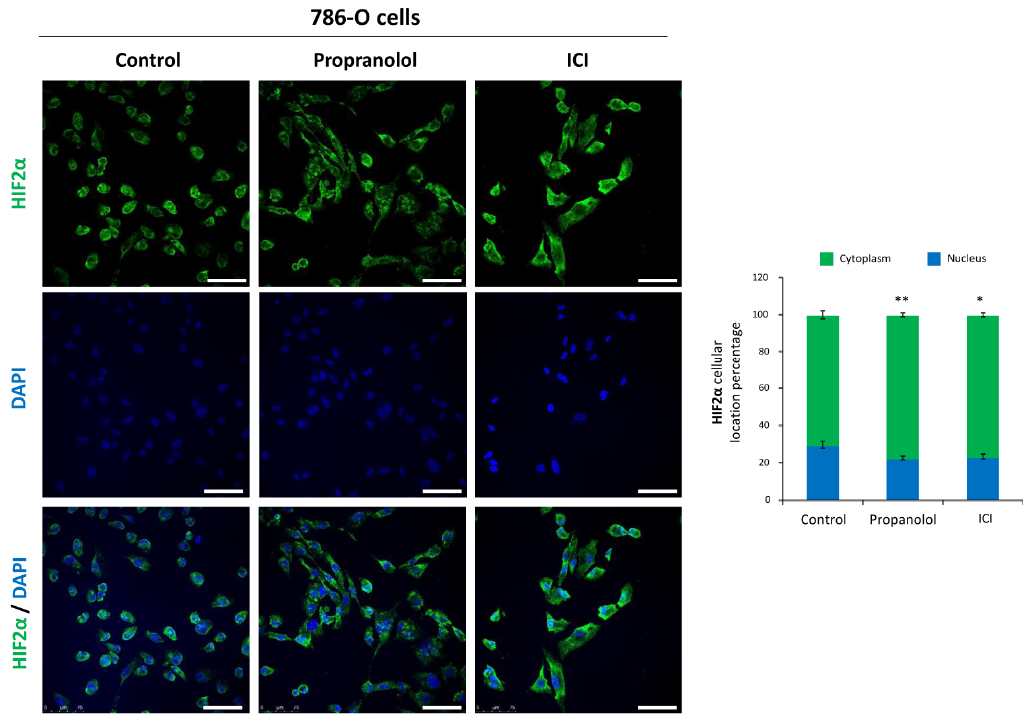
Figure 3. Effect of β 2-adrenergic receptor blockage on HIF-2 α subcellular distribution. Left, immunofluorescence detection and confocal microscopy representative images from 786-O cells treated with 100 µM propranolol or ICI for 72 h. Mouse anti-human HIF-2 α antibody stains (green), DAPI nuclear staining (blue) and merged are shown. Right, relative quantification of HIF-2 α nuclei or cytoplasmic distribution. For quantification procedures, 12 different optic fields were taken from 4 replicates per condition. Scale bars represent 50 µm. Error bars denote ± SEM. Student’s t -test: * p < 0.05; ** p < 0.01; *** p < 0.001.